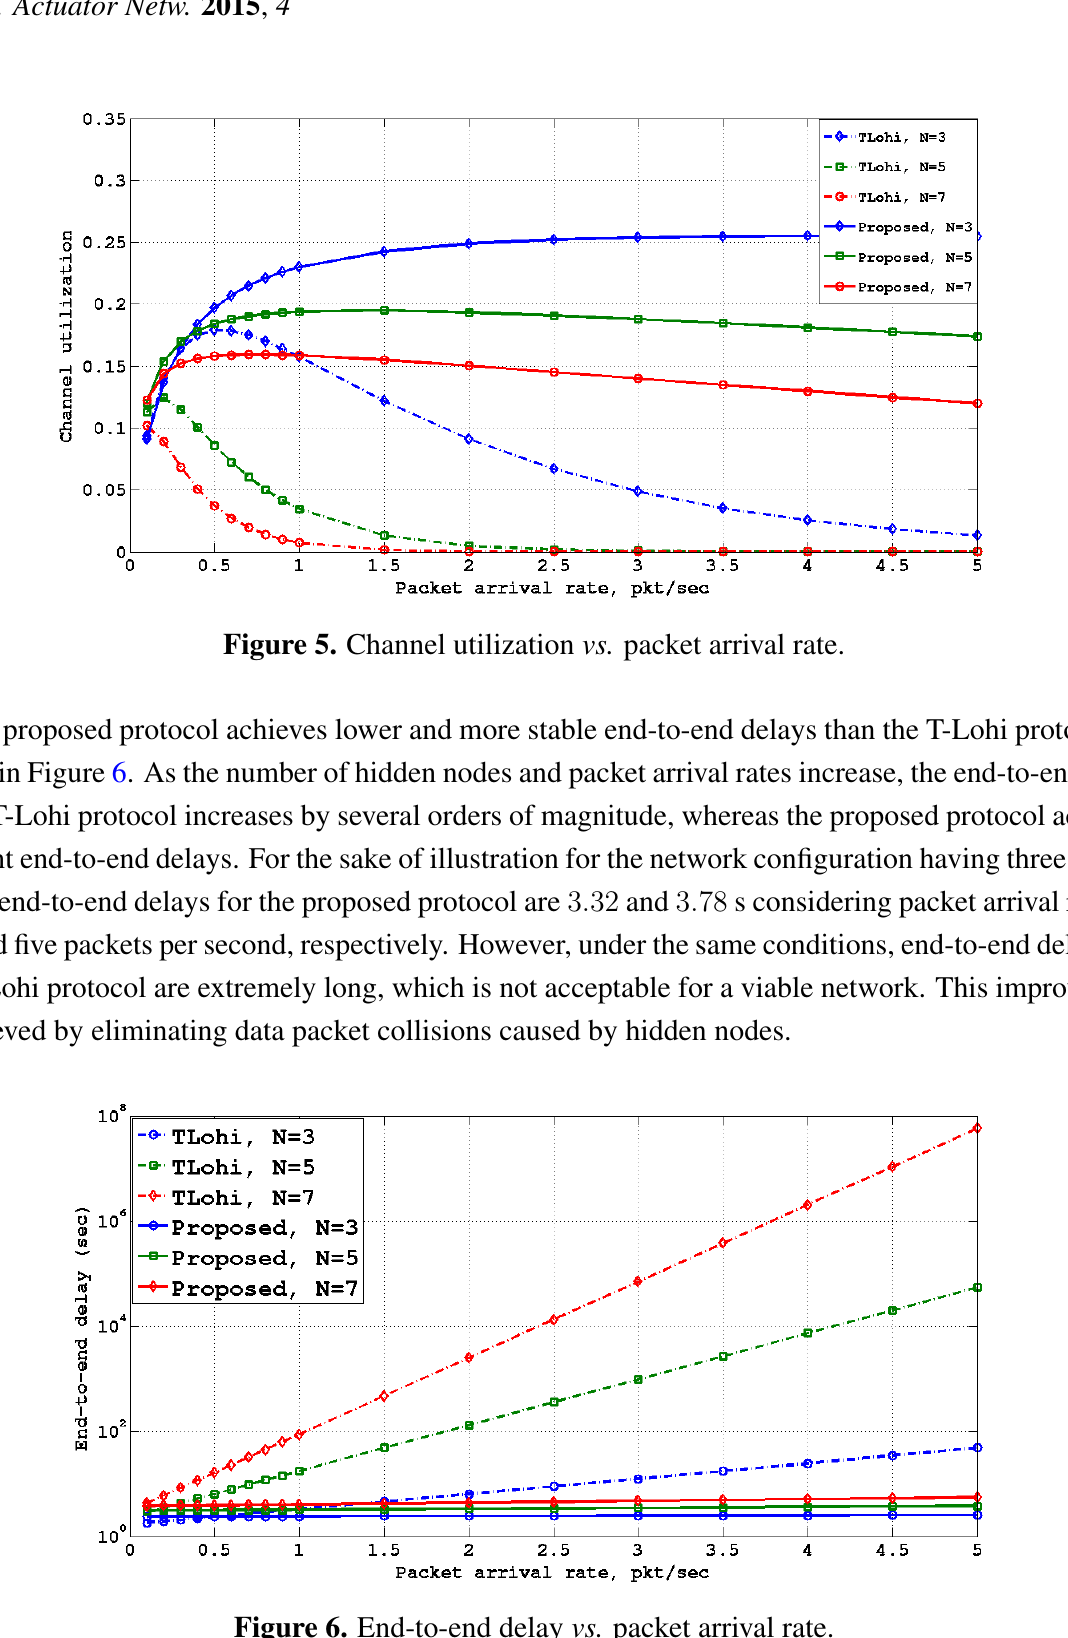
Figure 6. End-to-end delay vs. packet arrival